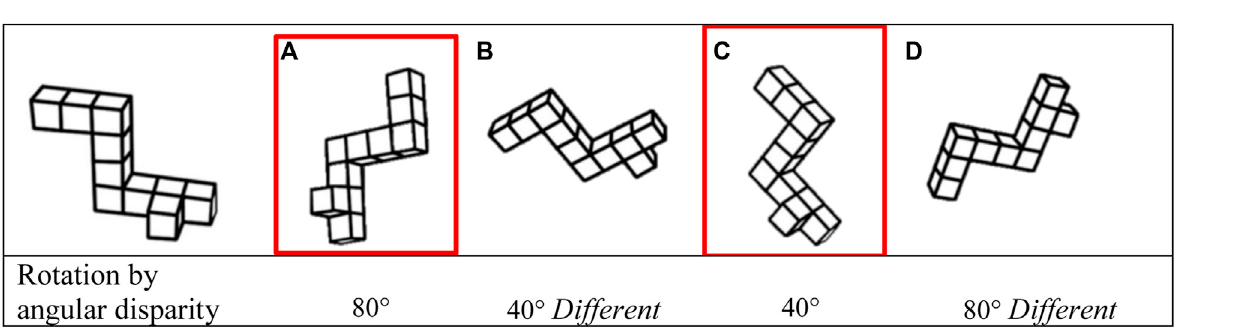
Choices A and C are correct